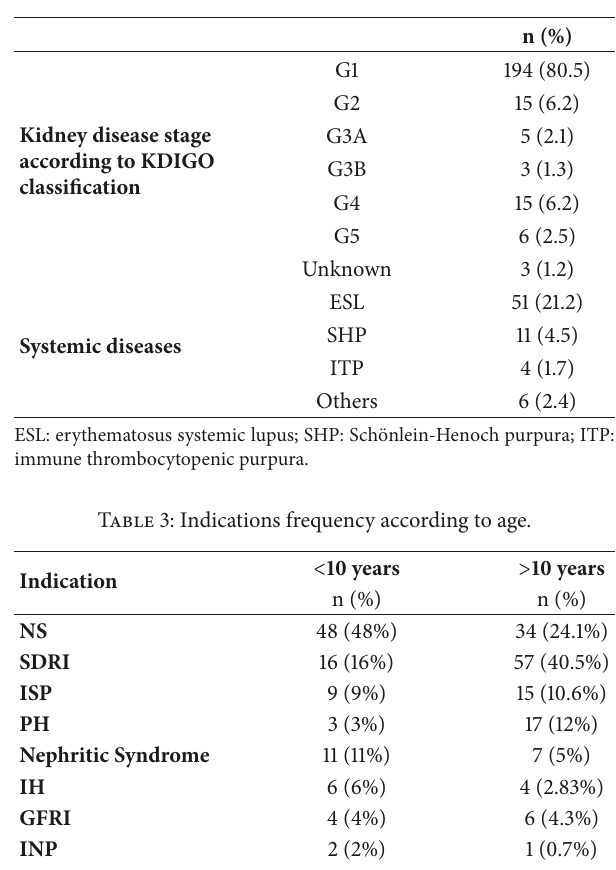
Kidney disease stage